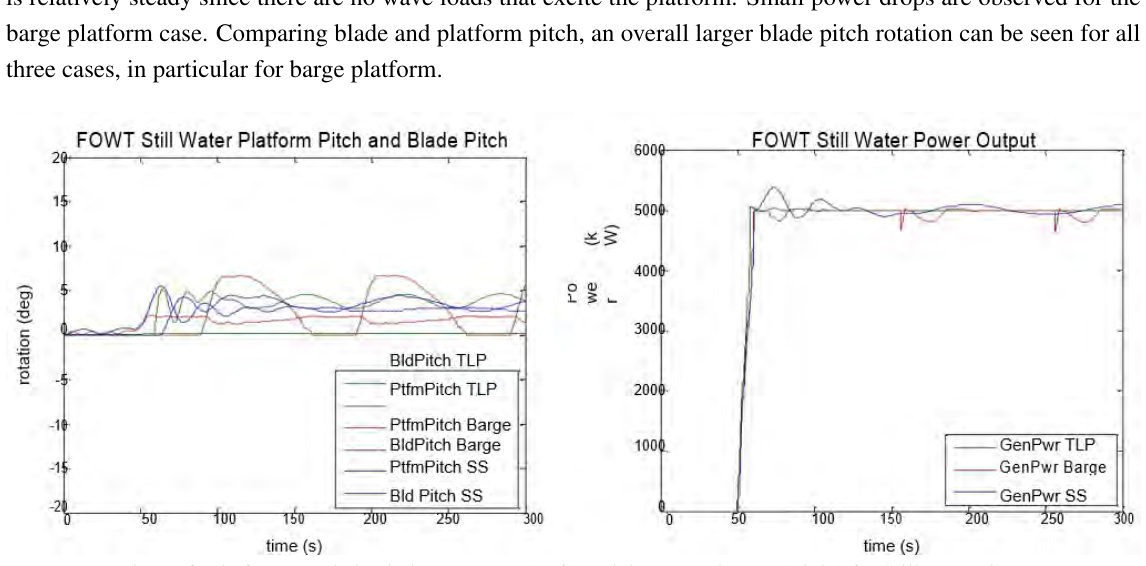
Figure 6. Platform vs Blade Pitch Responses (Left) and thePower Output (Right) for Still Water Case For the periodic wave case, the three configurations are analyzed with the same parameters as the still water case, except for HydroDyn module input parameters: Airy wave is selected as wave load with period T = 11.3 sec and amplitude H = 5.49